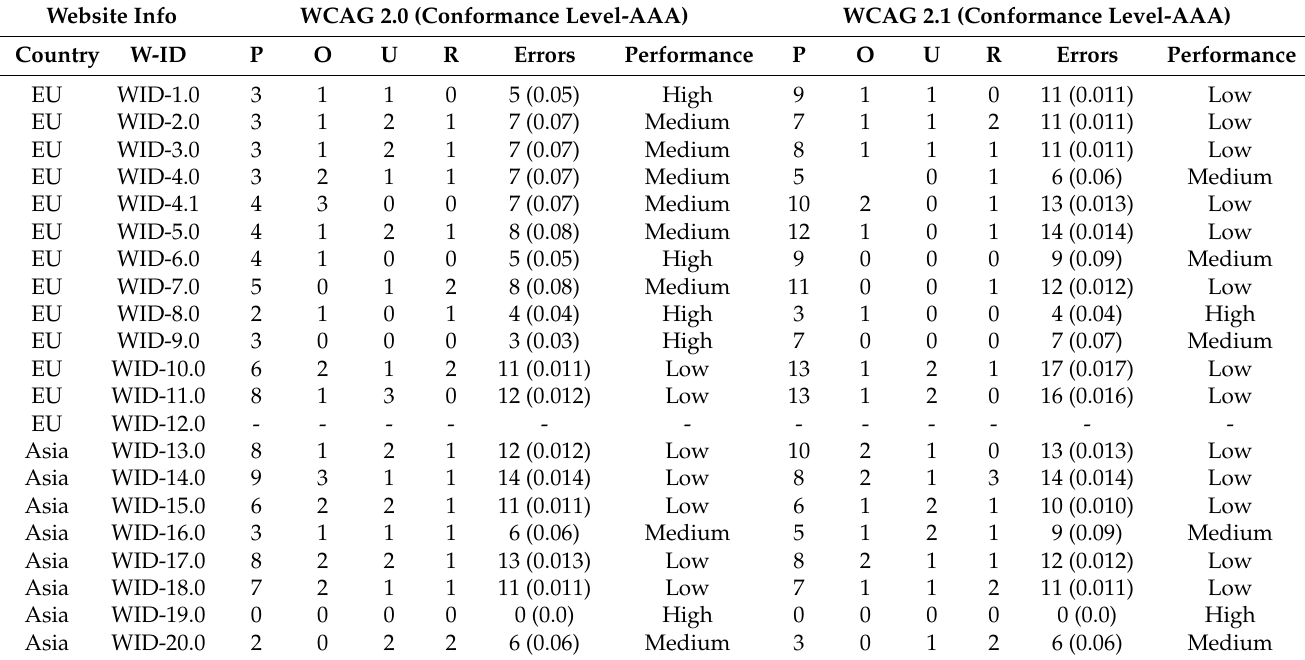
Table 5. Mauve test: Government website accessibility testing result for WCAG 2.0 and WCAG